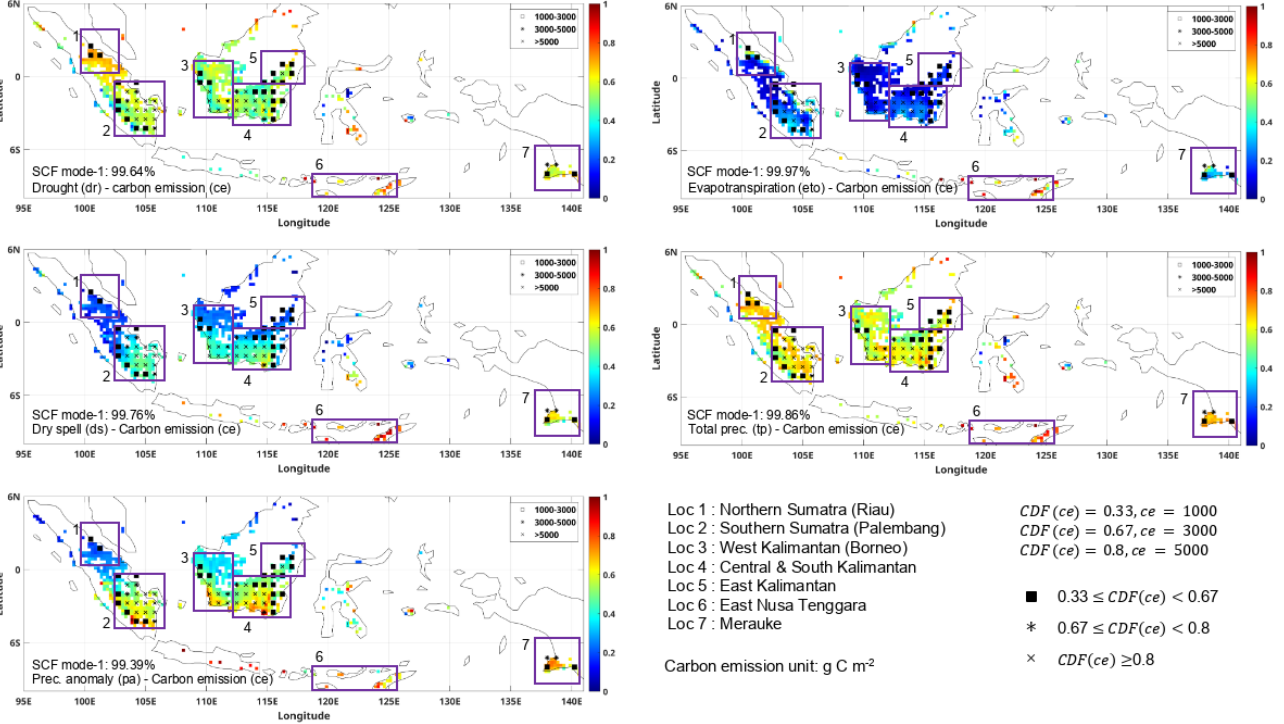
Figure 3. Joint spatial pattern of carbon emissions paired with drought indicators. The joint temporal pattern of each drought indicator with ce has a similar behavior in describing carbon emission, where the slightest error obtained is from eto , and the most error is obtained from pa (Figure 4). Compared to Figure 2, the difference occurred on dr and ds . The dr temporal pattern in Figure 4 has less errors than ds , which is opposite to Figure 2. Moreover, the most errors did not occur in 1997 and 1998, but in 2013. All temporal patterns failed to capture the high ce in the 2013 fires event. This behavior indicates that the fire event in 2013 produced a significantly high amount of ce burned area in other years. A similar behavior of high negative errors also occurred in high number of errors. Even more, most of the errors are in the negative value range. extinguishing attempt cannot always significantly reduce produced ce from the fire event. These results indicate that prevention is more critical than extinguishing attempts. Even though the ba can be reduced significantly, the produced ce is much harder to handle since it is more related to tp and eto (less value of errors).